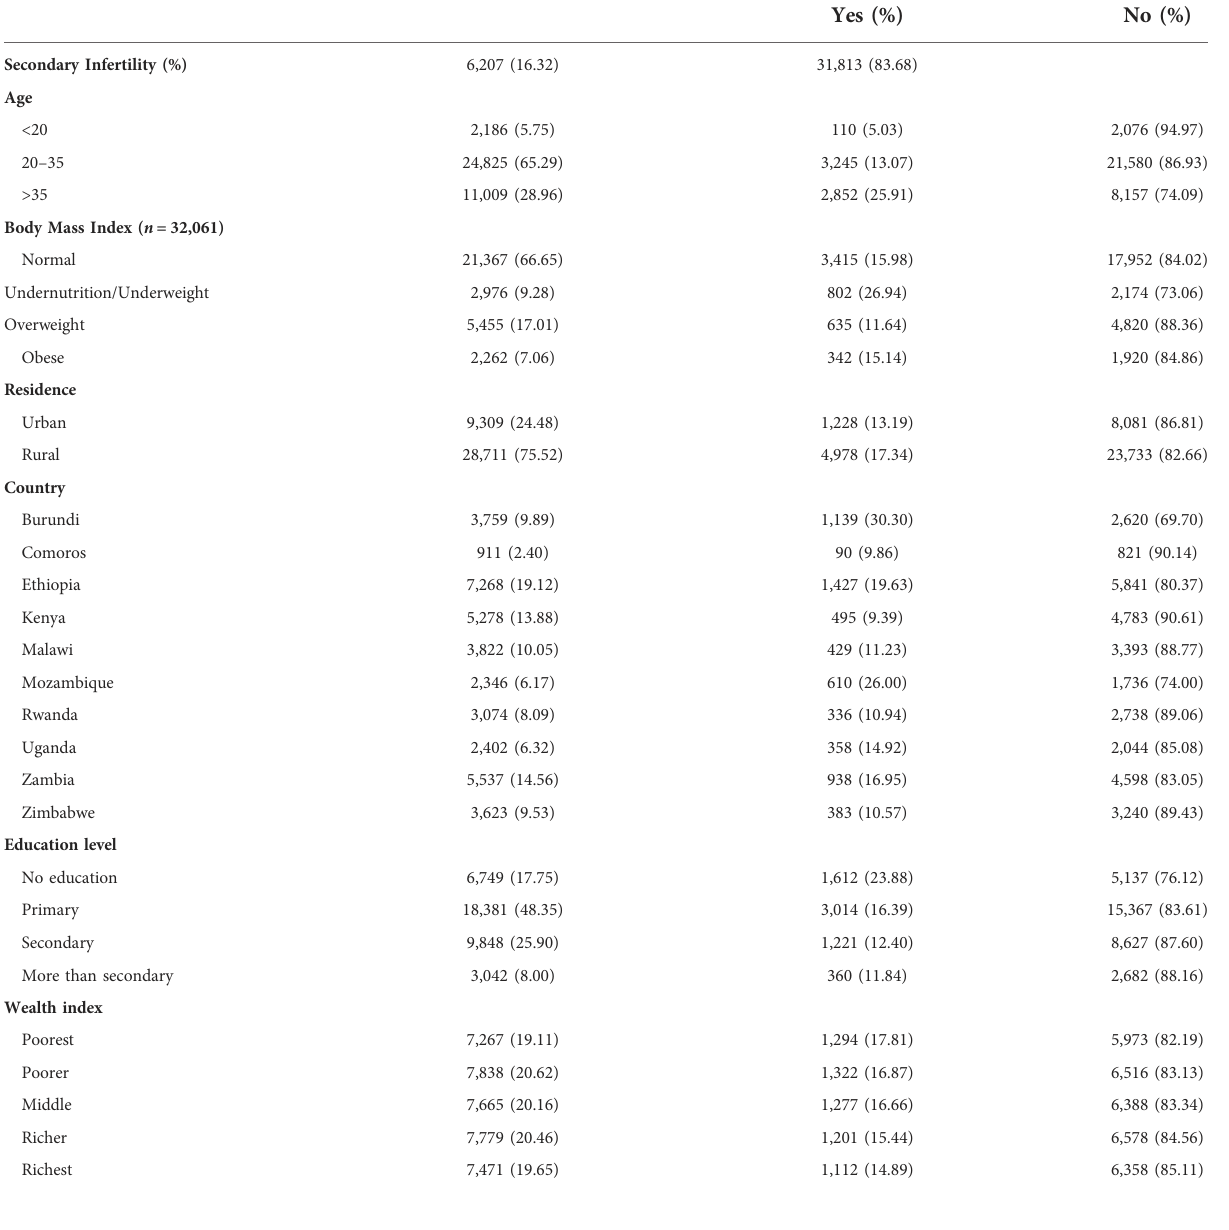
TABLE 2 Socio-demographic characteristics of women in East Africa